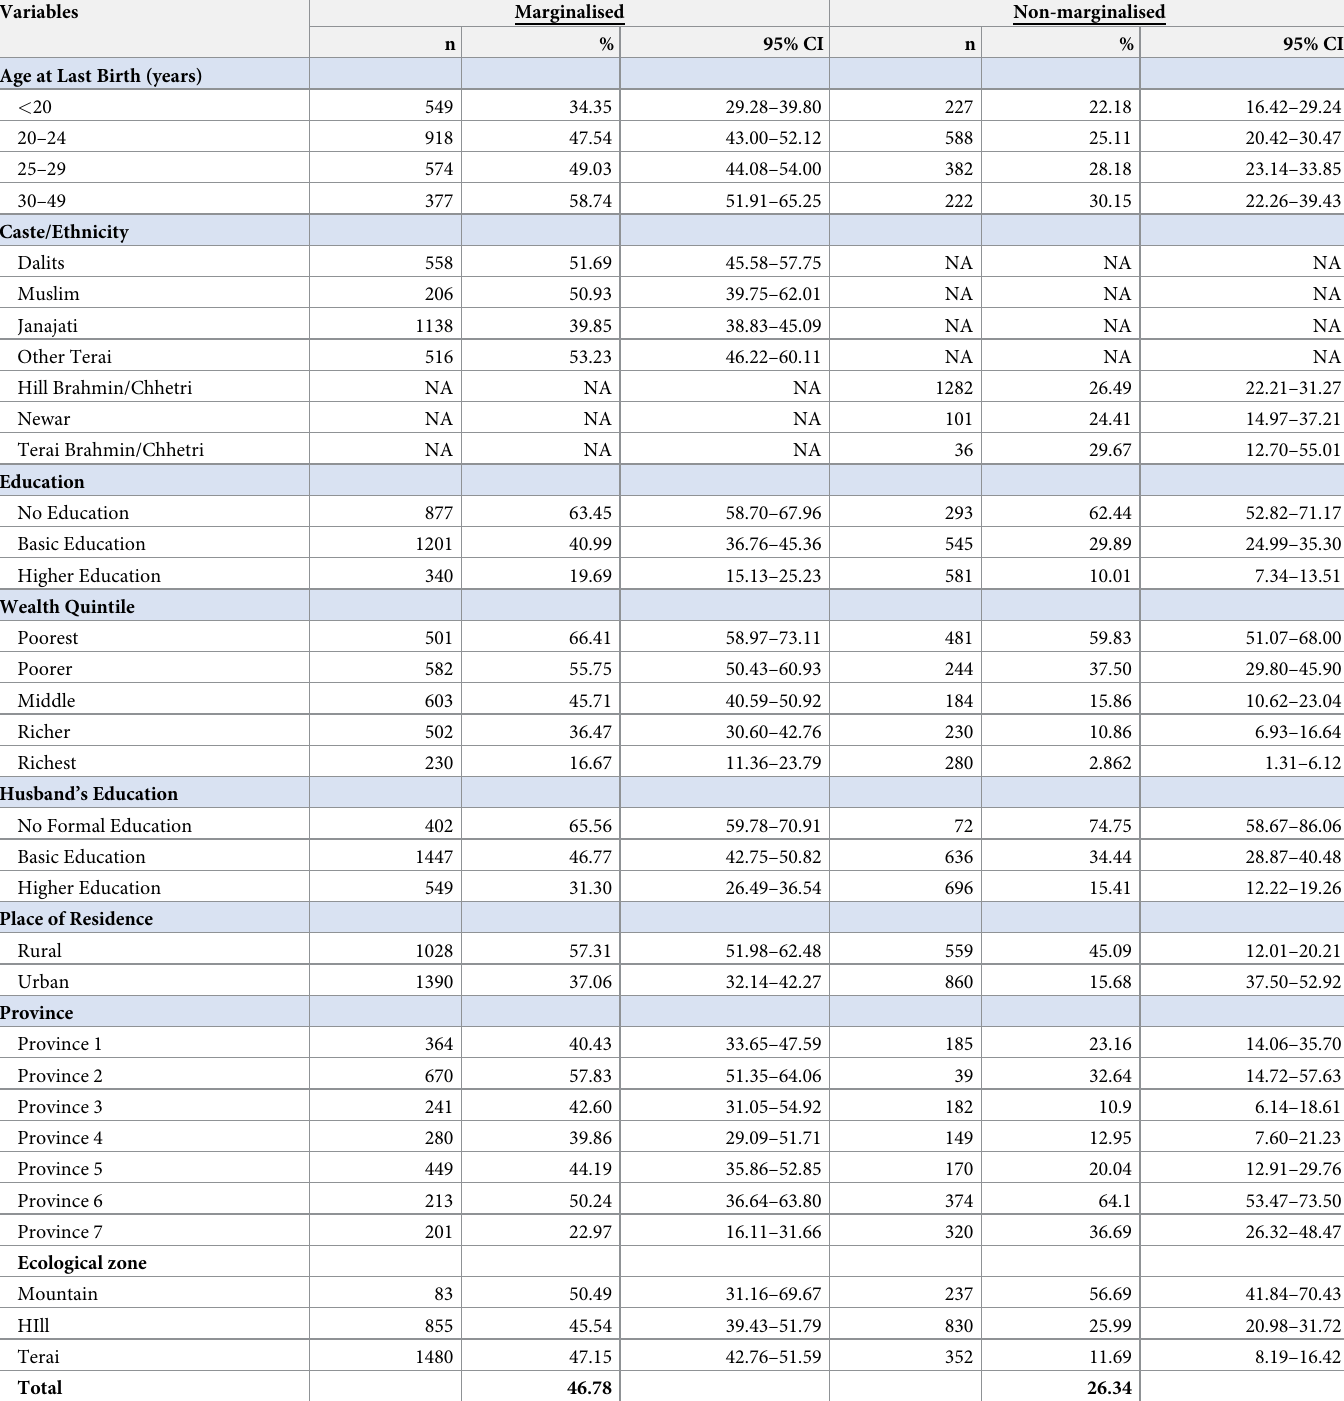
Table 3. Percentage of marginalised and non- marginalised women delivering their last child at home, according to background variables. Variables